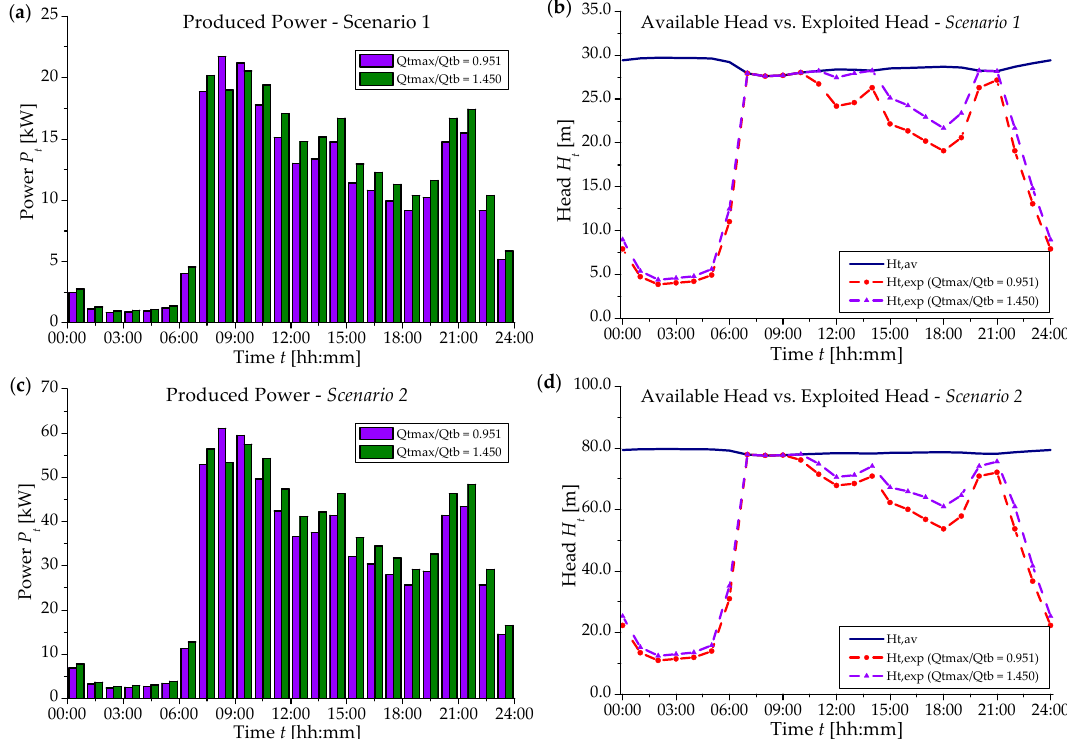
Figure 1. Produced power P t for ( a ) Scenario 1 and ( c ) Scenario 2 and comparison between available head H t , av and exploit head H t , exp for ( b ) Scenario 1 and ( d ) Scenario 2